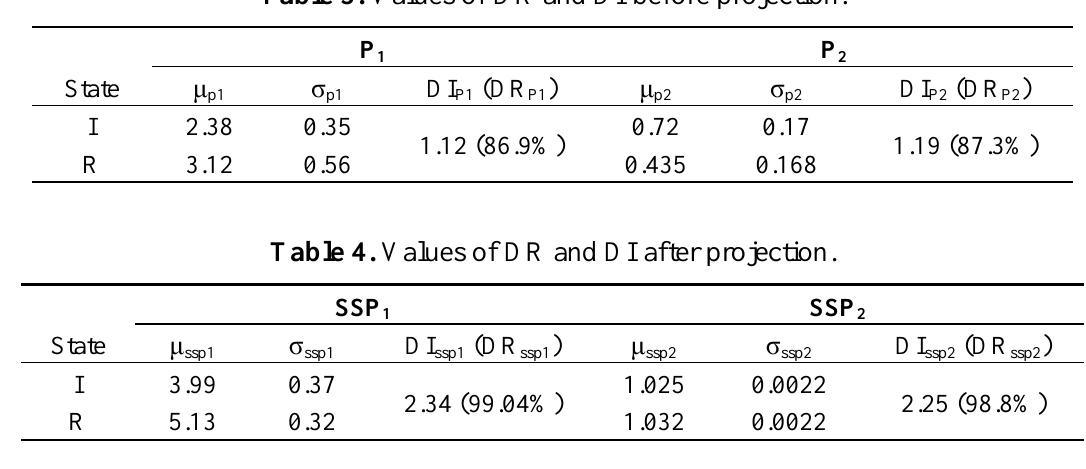
Table 3. Values of DR and DI before projection.